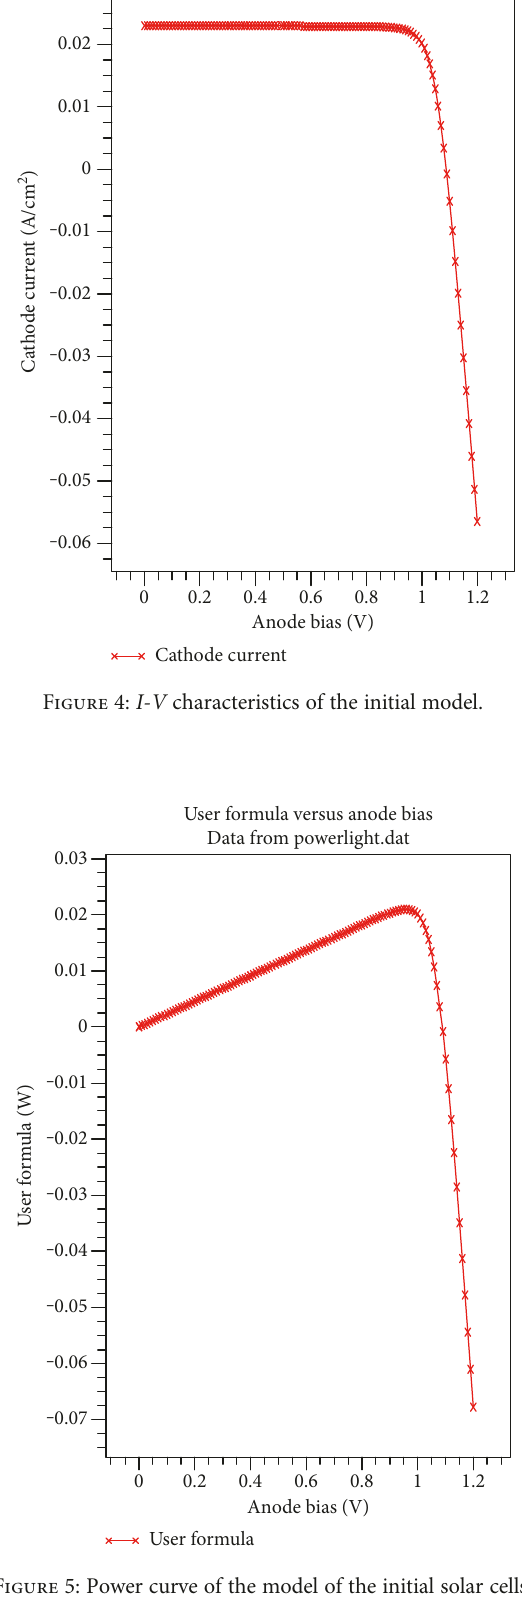
Figure 5: Power curve of the model of the initial solar